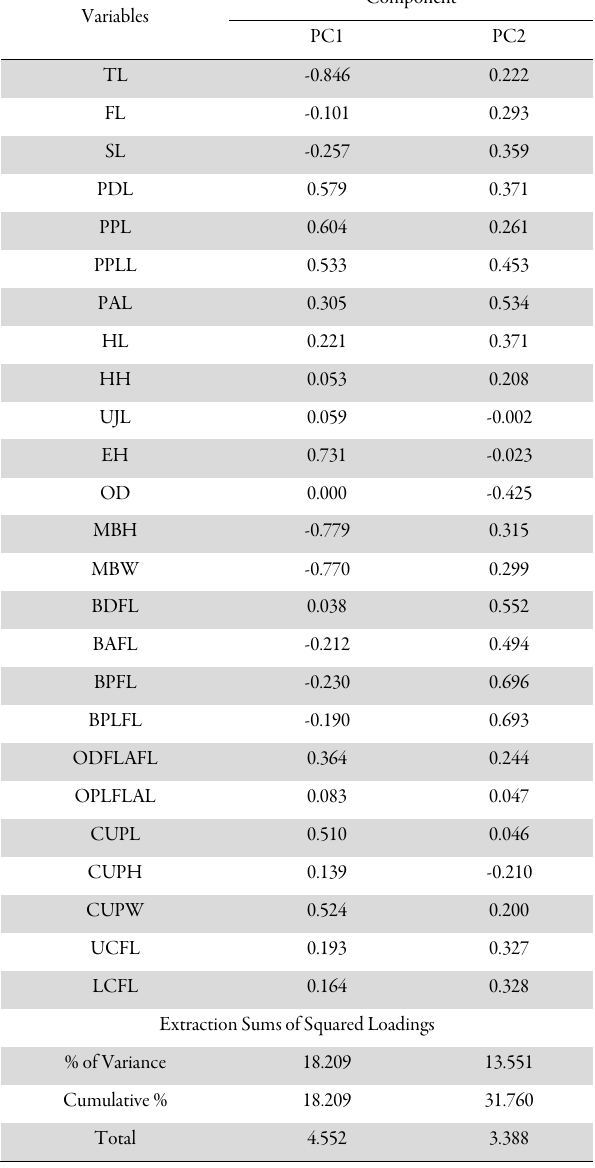
Table 3. Variations associated with principal components and sum of squared loadings for the morphometric measurements of four populations of E. machnata